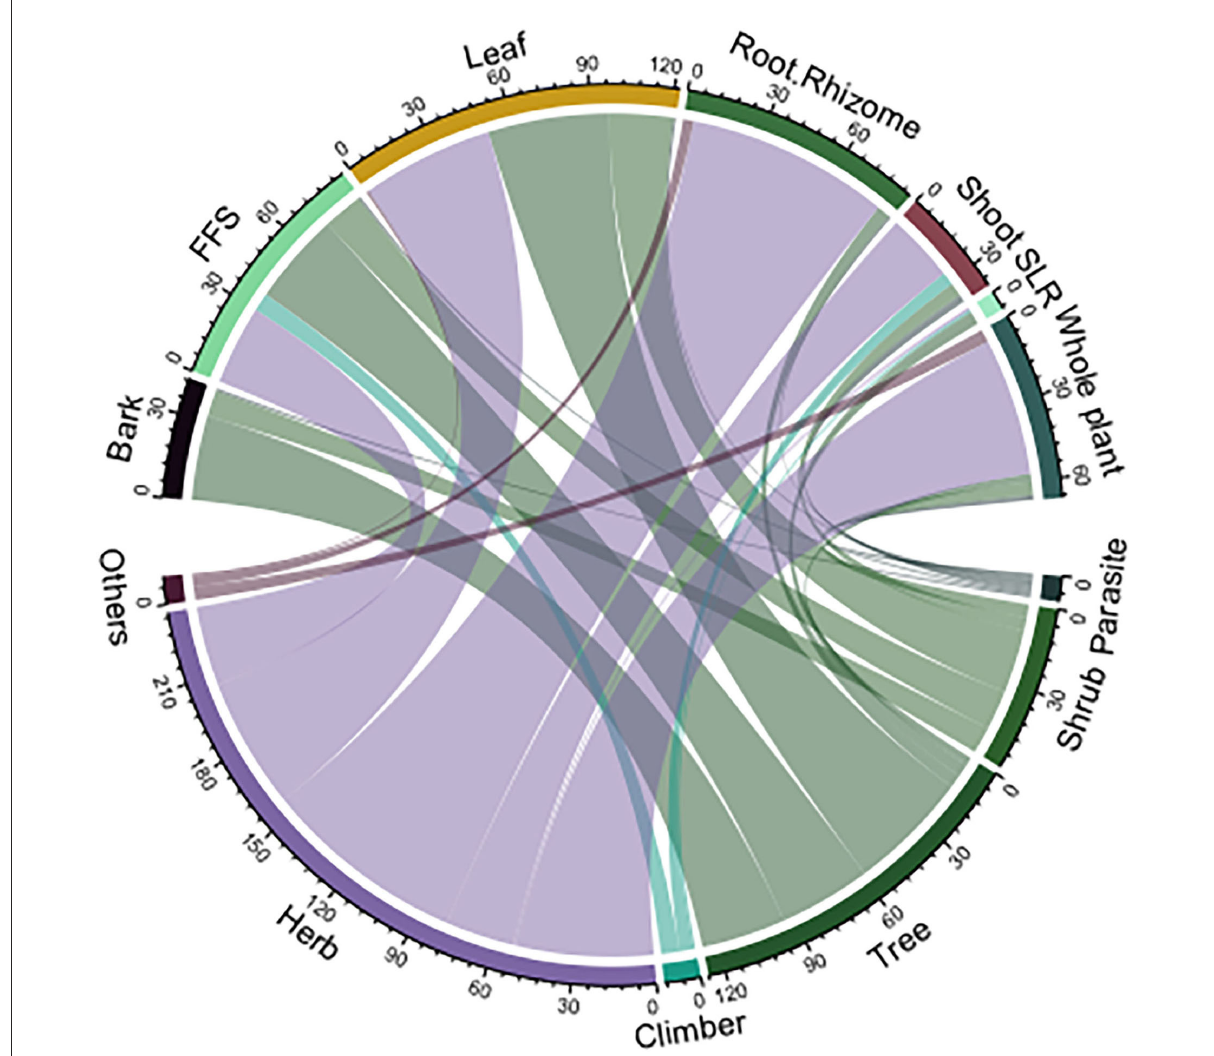
FIGURE3 Chord diagram showing plant growth forms and parts used (see main text for